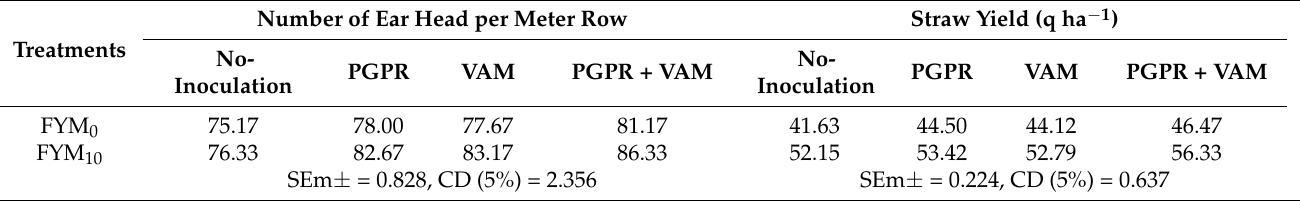
Table 5. Interaction effect of FYM and composite PGPR on the number of ear head and the straw yield of wheat (mean data of two years). Table 7. Effect of fertility levels, FYM, and bio-inoculants on the economics of wheat (mean of two years).